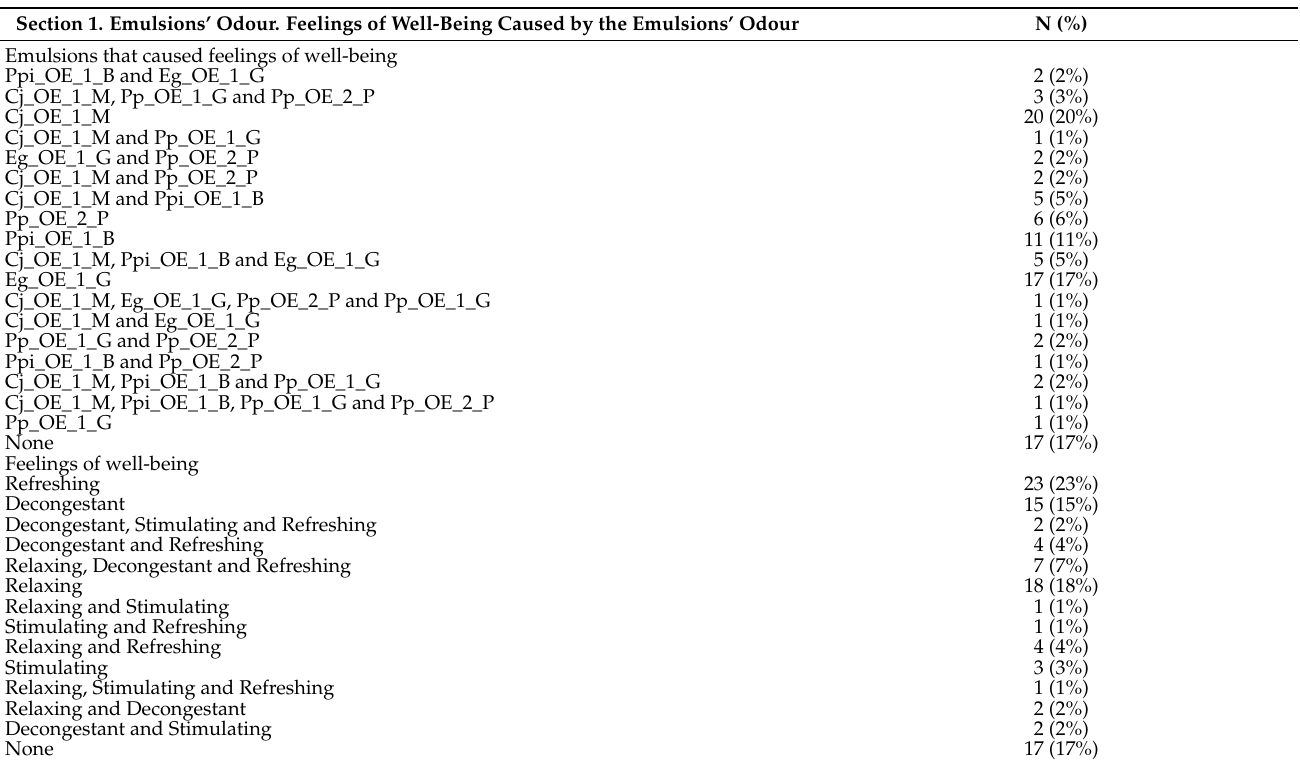
Table 7. Participants responses about the feelings of well-being caused by the emulsions’